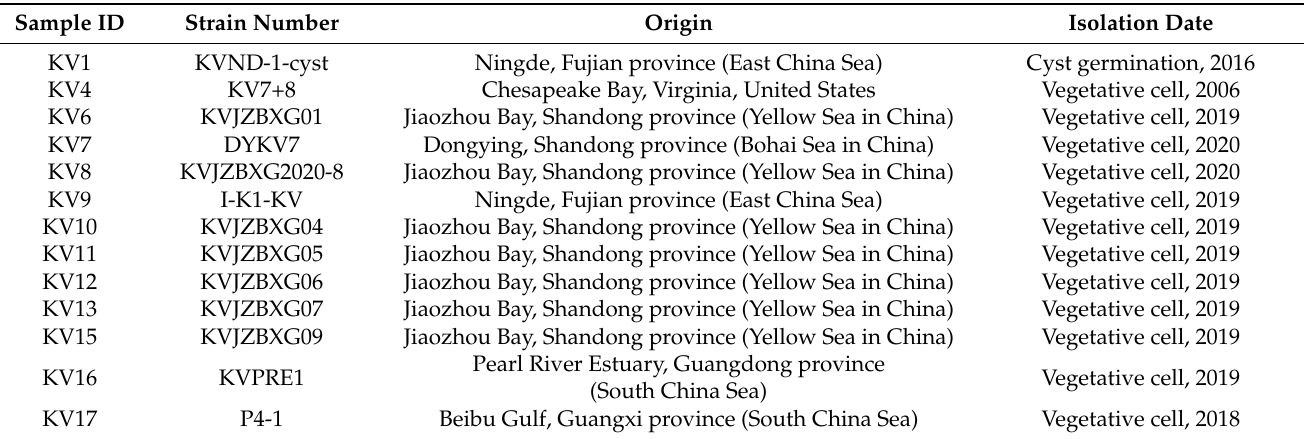
Table 2. Details of 13 K. veneficum